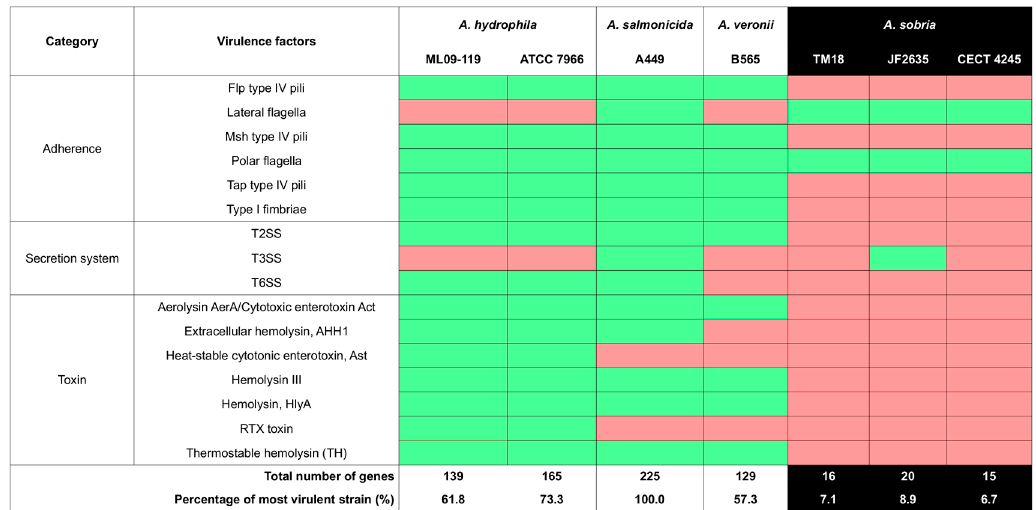
Figure 2. Candidate probiotic P. fluorescens ML11A is devoid of several virulence factor genes found in pathogenic Pseudomonas strains. Green: one or more genes that encode a given virulence factor (VF) are present. Red: no VF-encoding gene found. Columns for candidate probiotic and conspecific non- antagonistic strains are highlighted in black.